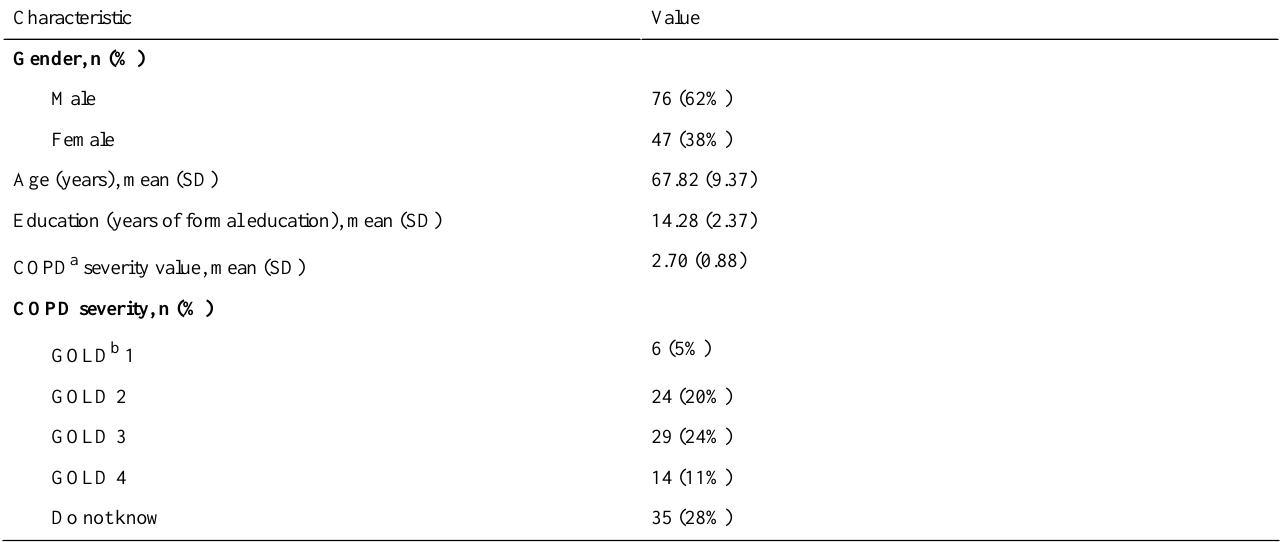
Table 6. Descriptive statistics of the participants in Study 2